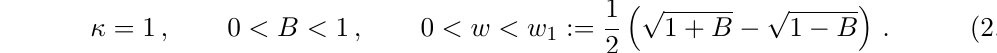
orbifold singularity at the ‘